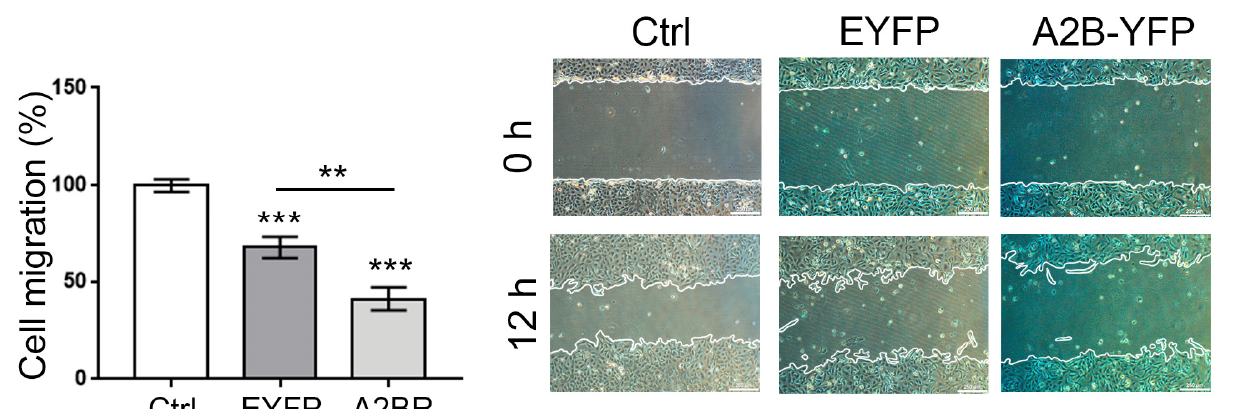
Figure 4. Overexpression of A2BR inhibits basal migration of SKOV-3 cells. SKOV-3 cells were transfected with a plasmid coding for A2BR fused with yellow fluorescent protein (YFP) at the carboxy-end; another plasmid coding only for YFP was used as a control. After transfection, cells were cultured to reach confluence (48 h) and a scratch assay was performed. Pictures show the wound at the time it was made and 16 h after. In the graphs, bars represent the mean ± S.E.M. of three independent experiments. ** p < 0.05, *** p < 0.01. Scale bar = 250 µ m.